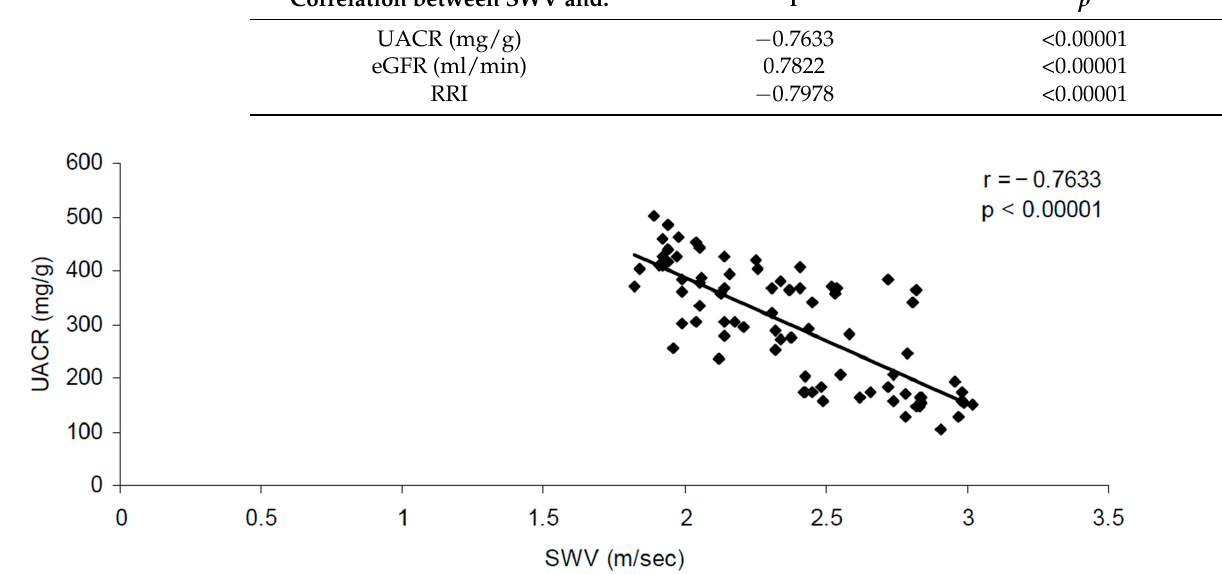
Figure 3. Correlations between SWV and UACR.